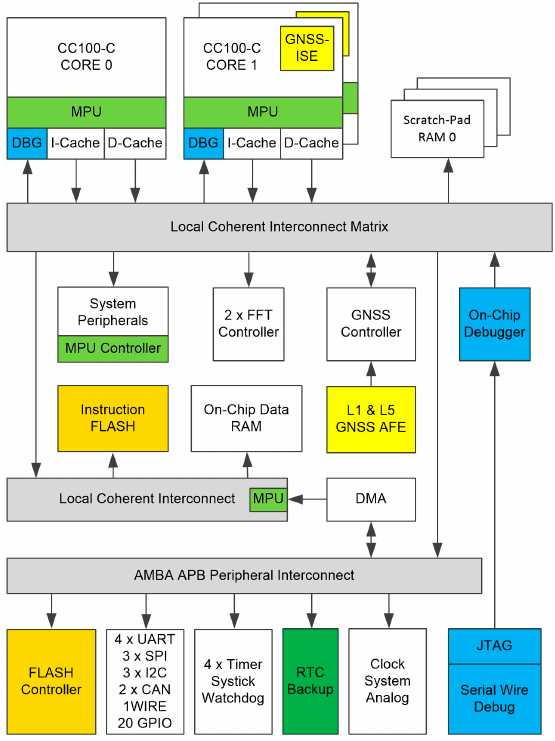
Figure 1. Block diagram of the CCNV1-A1 GNSS receiver system-on-chip (SoC).